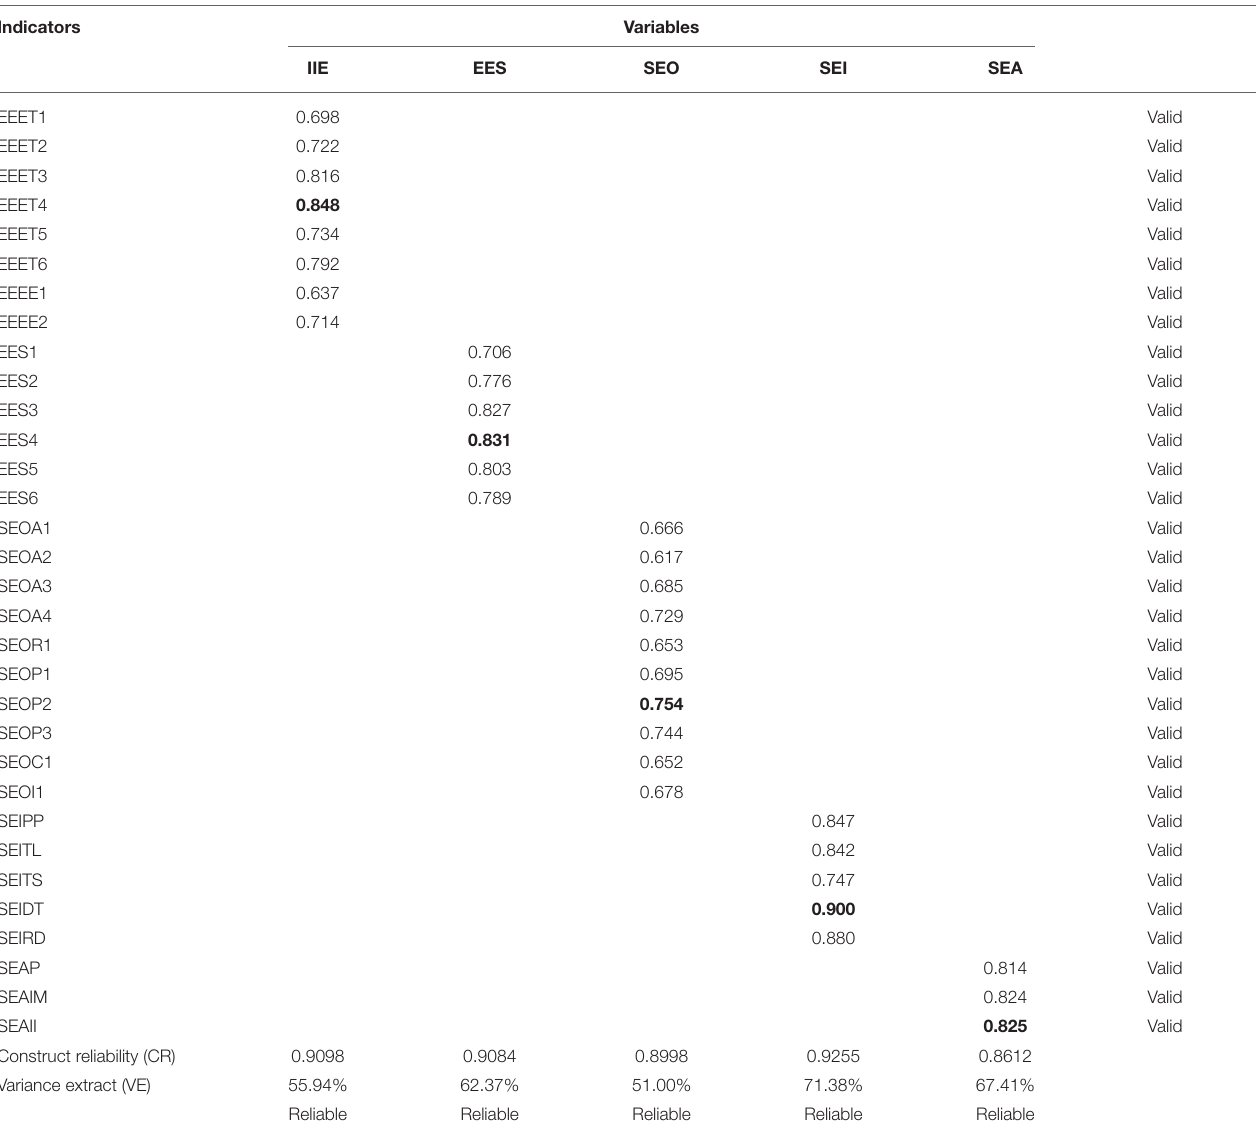
The bold values indicates the largest loading factor value for each of the IIE, EES, SEO, SEI, and SEA variables.